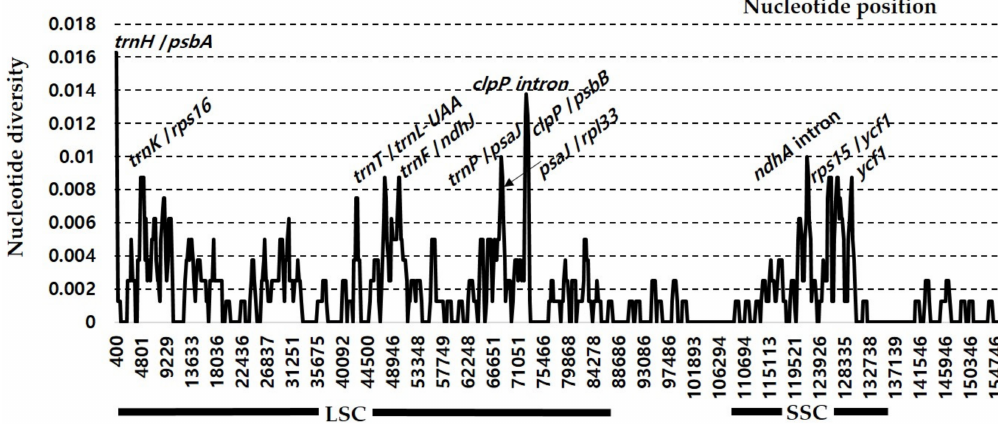
Figure 4. Sliding window analysis of the whole chloroplast genomes of R. boninensis and R. trifidus